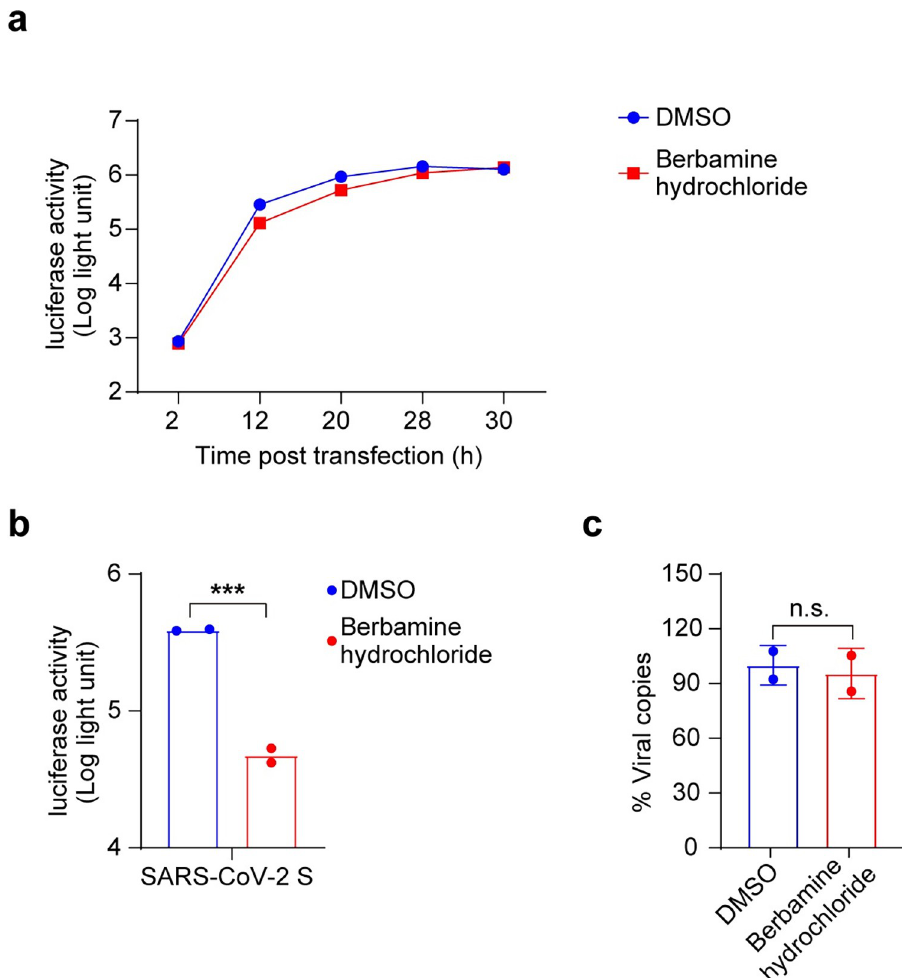
Fig 3. Mode-of-action analysis. (a) Transient replicon assay. (b) SARS-CoV-2 pseudovirus assay. Vero E6 cells were treated with the berbamine hydrochloride (10 μ M) or DMSO, and then infected with SARS-CoV-2 pseudovirus for 24 h. Luciferase activity in cell lysates was determined and compared with the DMSO control. (c) Impact of berbamine hydrochloride on SARS-CoV-2 attachment. Vero E6 cells were treated with berbamine hydrochloride (10 μ M) or DMSO for 1 h prior to SARS-CoV-2 infection at 4˚C for 1 h. The cells containing binding virions were collected for quantification of viral RNA copies by real-time RT-PCR assay. Data was expressed as mean ± standard deviation and shown are representative results of two independent experiments with two technical replicas per experiment. An unpaired two-tailed student’s t-test was performed for statistical analysis. n.s. not significant, � p < 0.05, �� p < 0.01 and ��� p < 0.001. Error bars represents standard